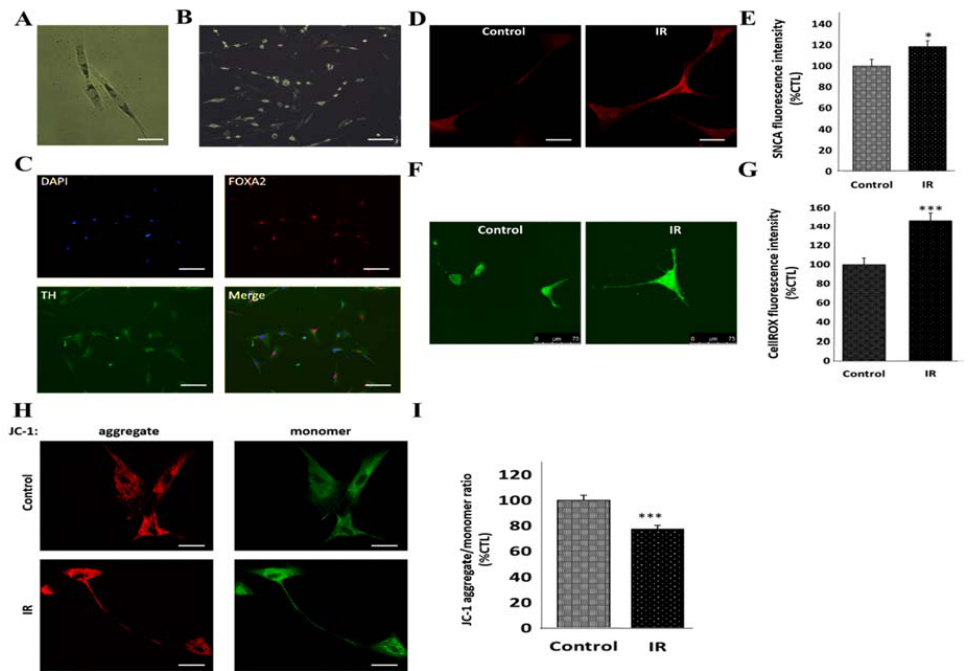
Figure 3. Insulin resistance is associated with increased expression of SNCA and mitochondrial dysfunction in human differentiated dopaminergic neurons, ex vivo. Photo images of ( A ) the fusiform fibroblast ‐ like adipocyte ‐ derived stem cells (ADSCs) obtained from the adipose tissue of non ‐ diabetic, non ‐ PD subjects, and ( B ) neuron ‐ like morphology with many neurite outgrowths, on day 21 of ADSC neuronal differentiation. ( C ) Immunofluorescence images of d ‐ hDA neurons characterized by TH (green) and FOXA2 (red) immunopositivity and outgrowth of neurites. ( D ) Representative images and ( E ) histograms of SNCA immunofluorescence intensity in d ‐ hDA neurons from patients with or without IR (control: 100 ± 6.3%, IR: 118.4 ± 5.6%, p < 0.05, n = 12). ( F ) Representative images and ( G ) histograms of CellROX live staining of d ‐ hDA neurons from patients with IR compared to non ‐ IR control, captured by confocal microscopy (control: 100 ± 7%, IR: 146.6 ± 8.1%, p < 0.001, n = 10). ( H ) Representative images and ( I ) graph of JC ‐ 1 (5,5 ′ ,6,6 ′‐ tetrachloro ‐ 1,1 ′ ,3,3 ′‐ tetraethylbenzimidazol ‐ carbocyanine iodide) aggregate/monomer live staining of d ‐ hDA neurons from patients with IR compared to non ‐ IR control. Reduced JC ‐ 1 aggregate (red)/monomer (green) ratio indicates the ΔΨ m depolarization in the d ‐ hDA neurons (control: 100 ± 4.1%, IR: 77.8 ± 3%, p < 0.001, n = 12). *, p < 0.05, ***, p < 0.001; d-hDA, differentiated human dopaminergic neuron; IR, insulin resistance; ∆Ψ m, mitochondrial membrane